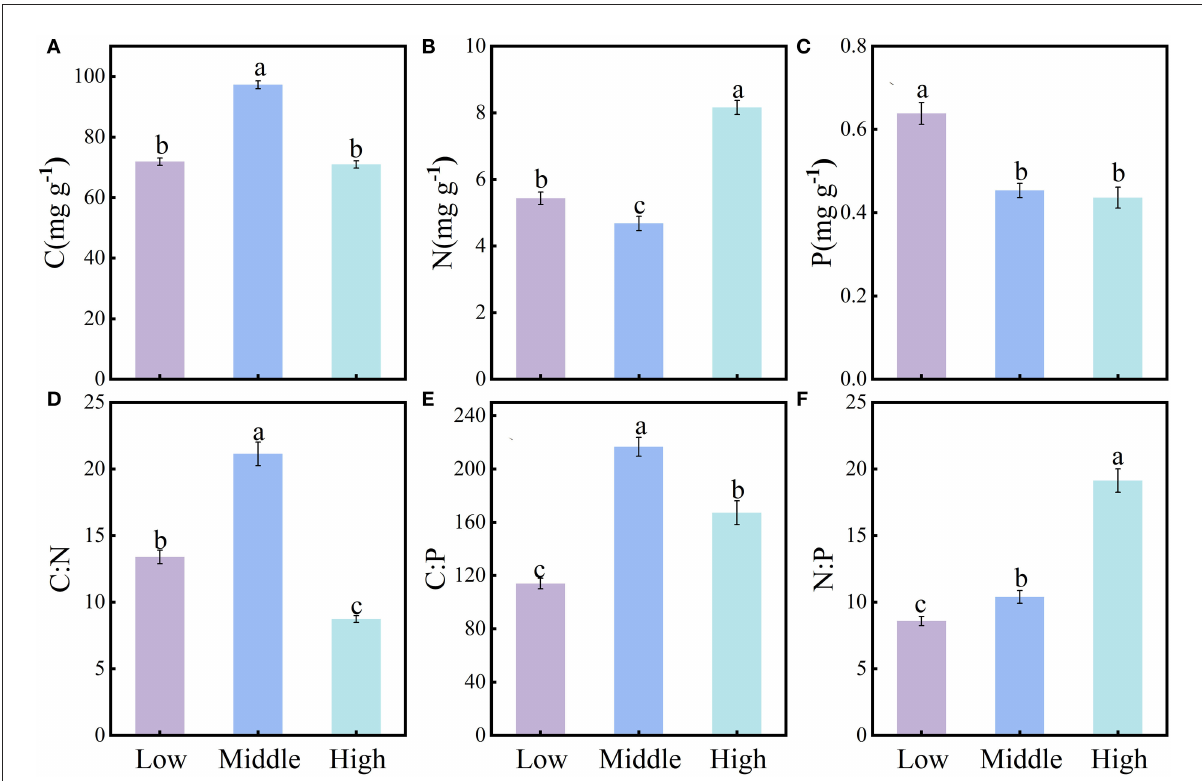
FIGURE2 Characteristics of soil stoichiometry at different elevation levels (mean ± SE, different lowercase letters indicate significant differences among them ( P < 0.05). Soil C, N, P content (A–C) ; soil C:N, C:P, N:P (D–F) .